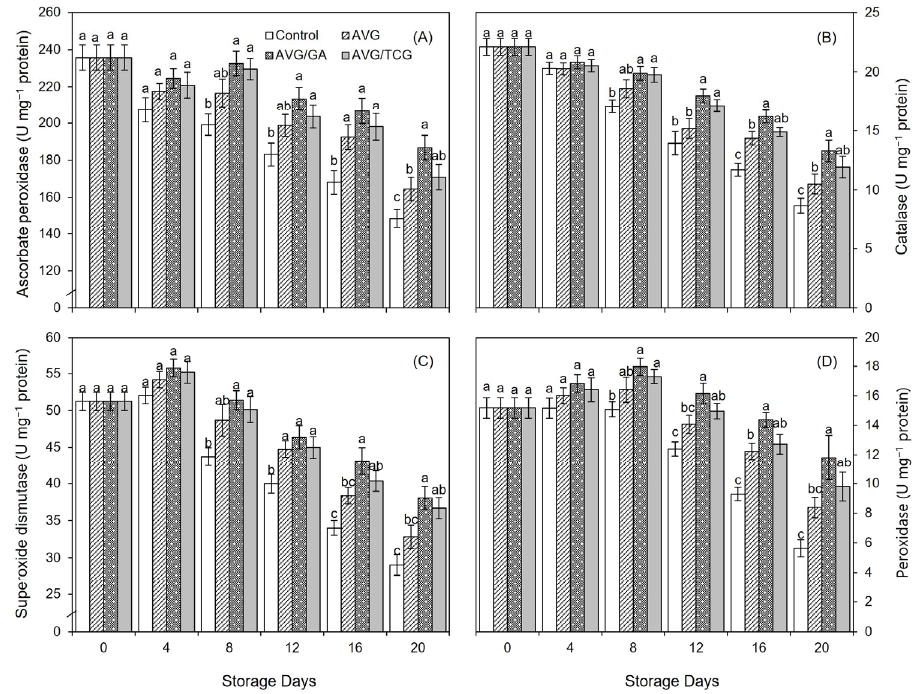
Figure 4. Effect of AVG-based composite coatings on ascorbate peroxidase activity ( A ), catalase activity ( B ), superoxide dismutase activity ( C ) and peroxidase activity ( D ) of persimmon fruits during 20 days storage (analysis on day 0, 4, 8, 12, 16 and 20) at 20 ± 1 °C and 80–85% relative humidity. All standard error bars are centered on means (3 biological replicates). Graph bars sharing same letters on a storage interval have non ‐ significance difference according to the LSD test at p ≤ 0.05.